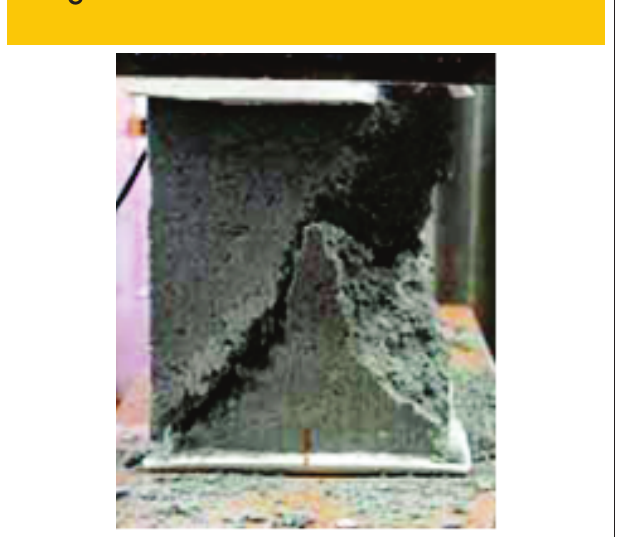
Figure 8 – Failure mode of concrete blocks